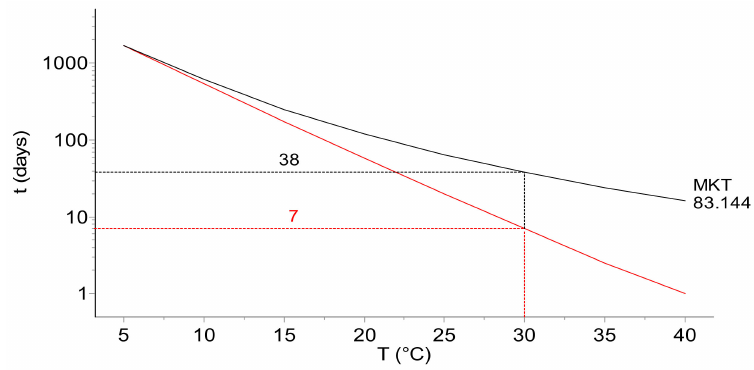
Figure 9. TTT (transformation–time–temperature) diagram presenting the shelf life as a function of the value of the excursion temperature after 30 days of storage in the cold chain (5 ◦ C). The simulations show the dependences for the real temperature (bold) and the MKT calculated by the assumption of the activation energy as E = 83.144 kJ · mol − 1 . At the excursion temperature of 30 ◦ C, the infectious titer loss, set arbitrarily to 5%, is reached after ca. 7 days. Note that the application of the MKT leads to severe overestimation of the shelf life. Depending on the assumed values of the activation energy, the same infectivity loss is reached after ca. 51 days for E = 42, 38 days for 83.1, and 29 days for 125 kJ · mol − 1 ,